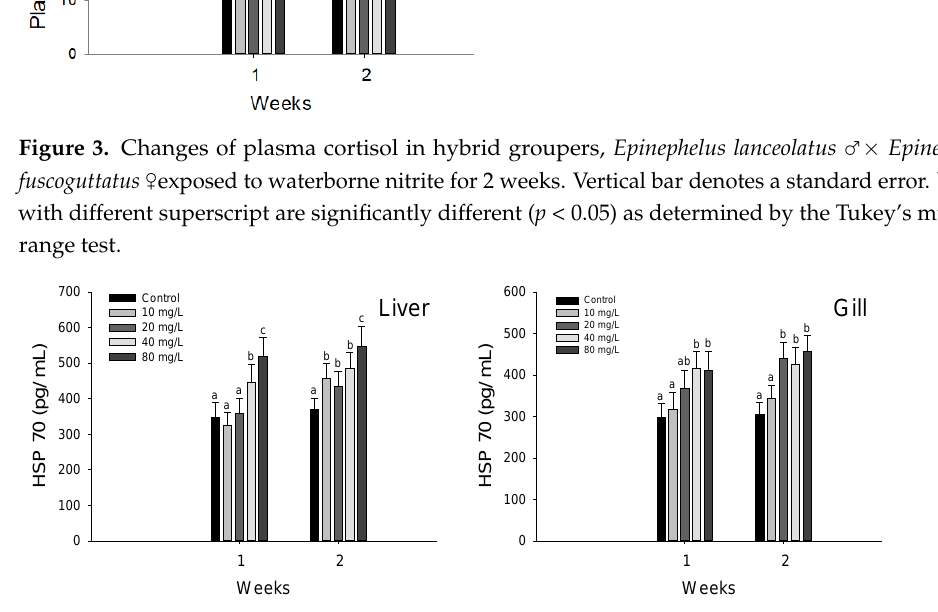
Figure 4. Changes of HSP 70 in hybrid groupers, Epinephelus lanceolatus ♂ × Epinephelus fuscogutta- tus ♀ exposed to waterborne nitrite for 2 weeks. Vertical bar denotes a standard error. Values with different superscript are significantly different ( p < 0.05) as determined by the Tukey’s multiple range test.